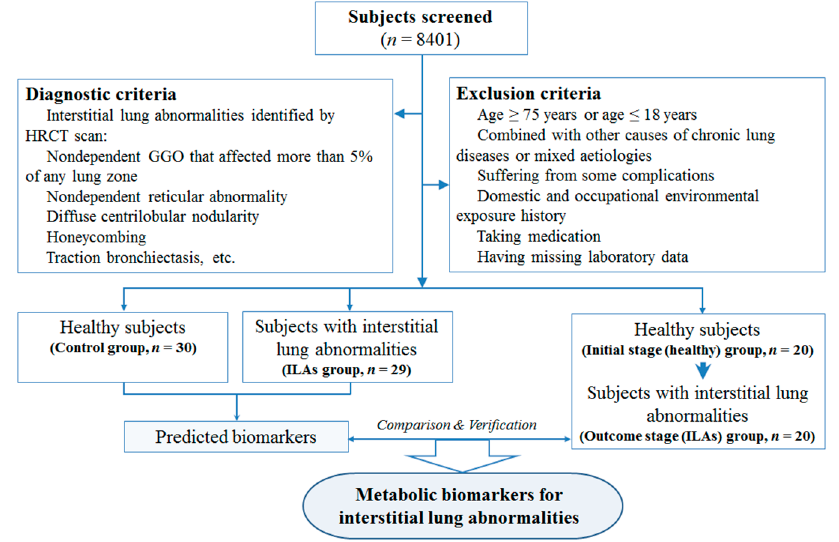
Figure 4. Clinical trial design flow diagram.